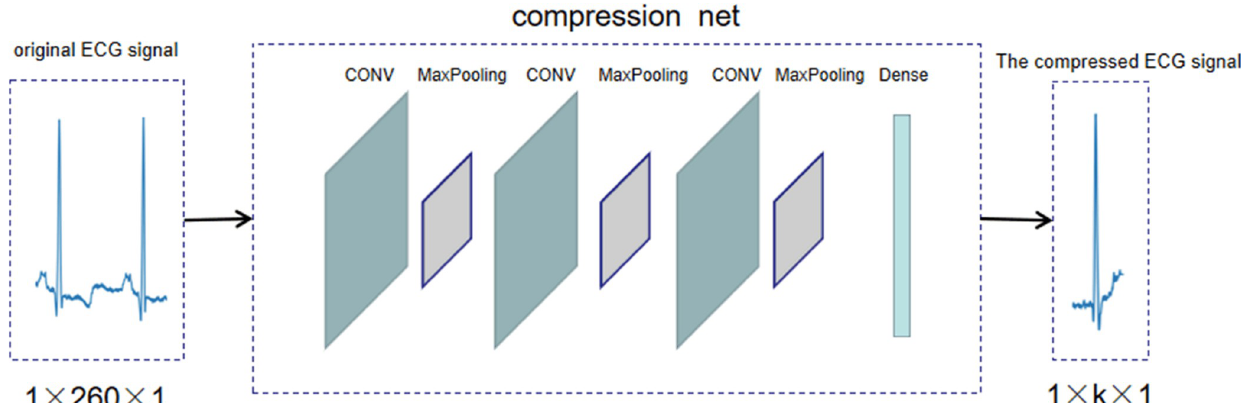
Fig 4. Proposed compression process.